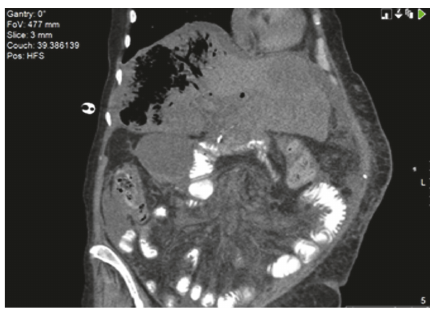
Figure 1: Parenchymal emphysema of the right hepatic lobe (trans- verse section). Figure 2: Parenchymal emphysema of the right hepatic lobe (long- itudinal